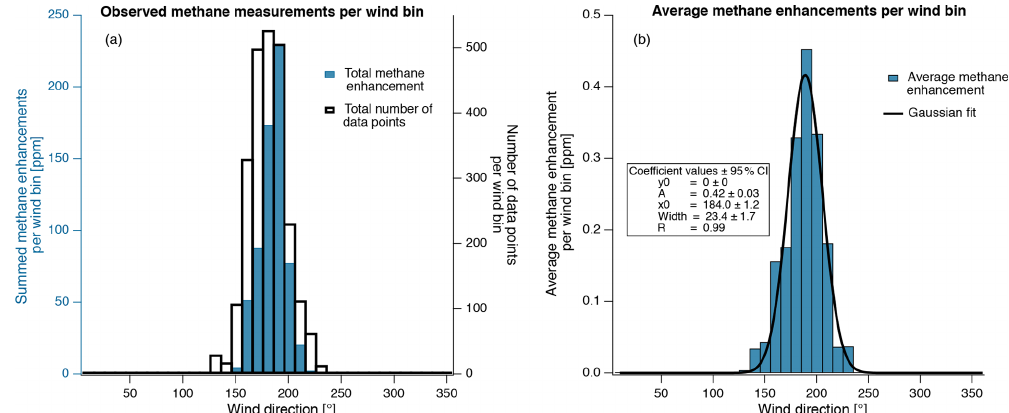
Figure 2. Summed methane enhancement and total number of data points in each 10 ◦ wind bin (a) . Average methane enhancement per 10 ◦ wind bin and Gaussian fit (b) . Goodness of fit parameter R is calculated following Eq. (S1) in the